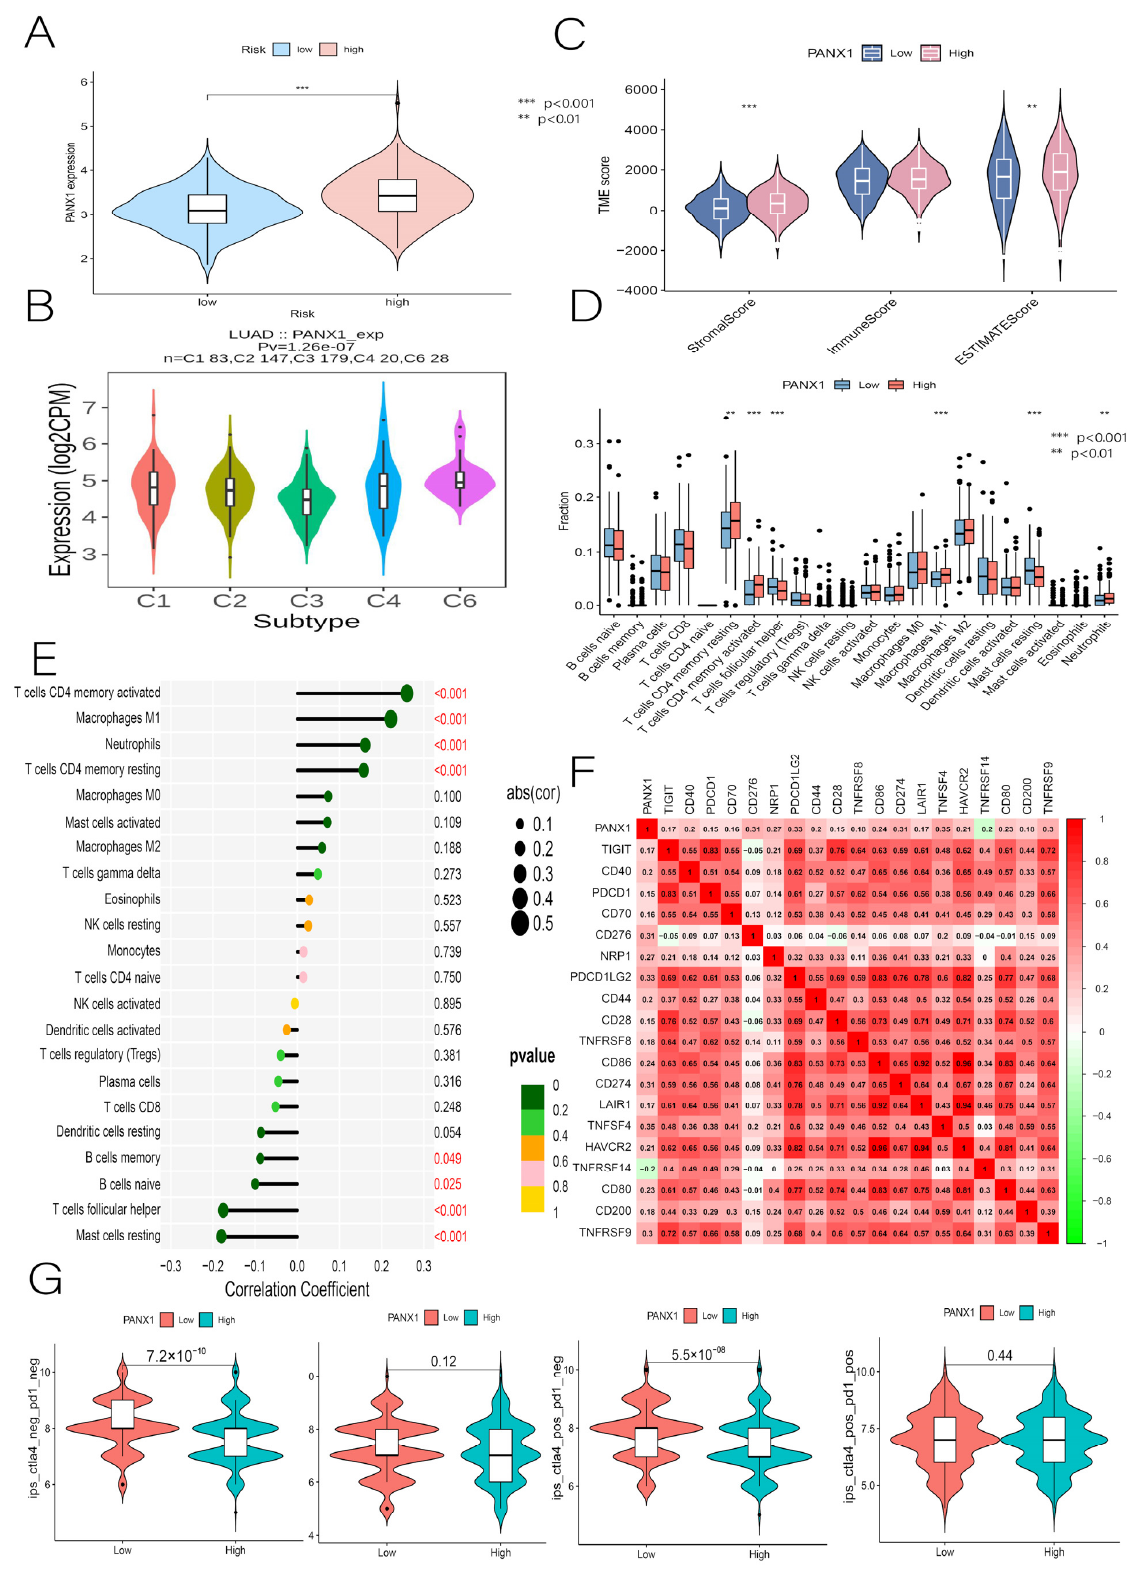
Figure 16. ( A ) Correlation of PANX1 with prognostic risk score. ( B ) Immunophenotyping of PANX1. ( C ) Relationship between PANX1 and TME. ( D , E ) Relationship between PANX1 and immune cell infiltration. ( F ) PANX1 and immune checkpoints. ( G ) Relationship between PANX1 and TCIA immunotherapy. ** p < 0.01, *** p <